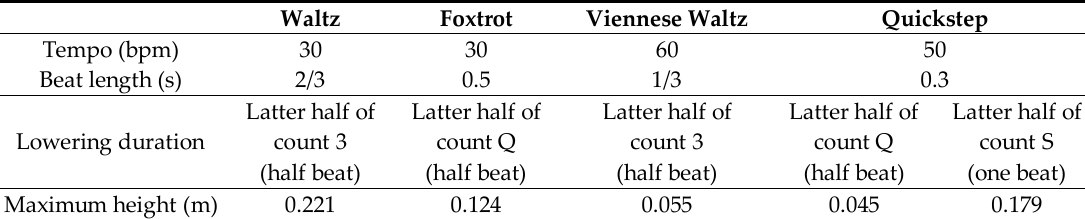
Table 1. Maximum allowable Rise and Fall range in swing